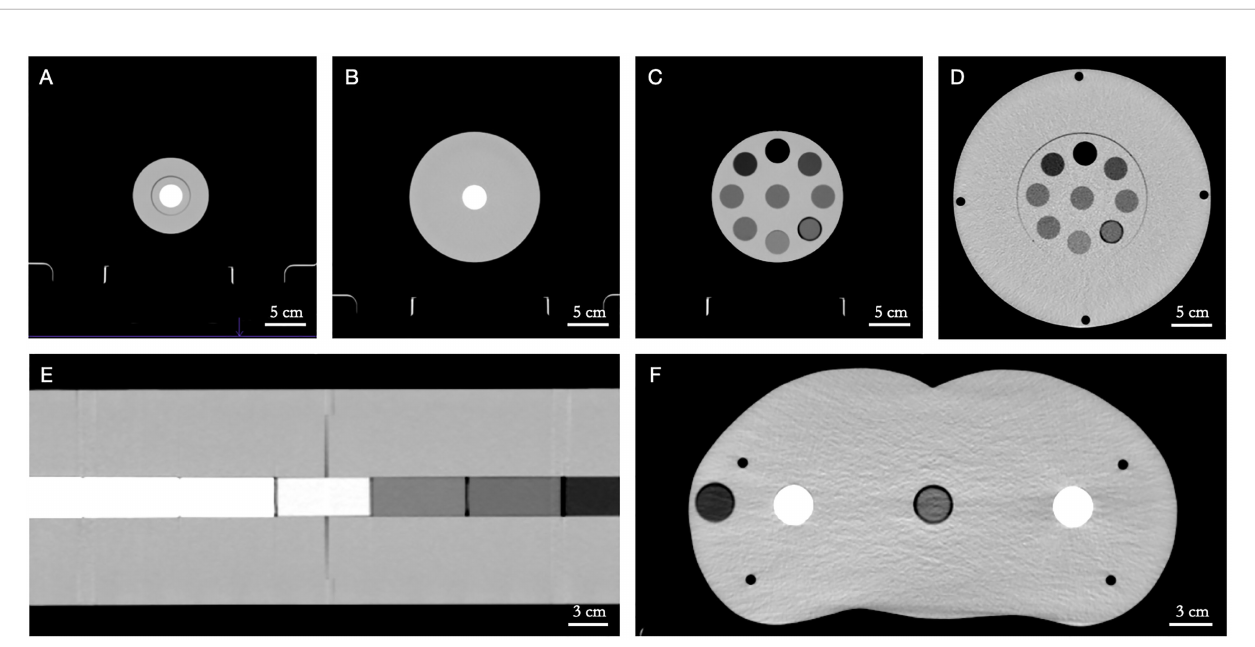
FIGURE 1 | Custom polymethyl methacrylate (PMMA) phantoms with tissue-equivalent inserts in axial view. (A) LCT ( “ long cylinder thin ” ) phantom, (B) LC ( “ long cylinder ” ) phantom, (C) SC ( “ short cylinder ” ) phantom, (D) SCB ( “ short cylinder big ” ) phantom, (E) LC ( “ long cylinder ” ) phantom (in coronal view), (F) pelvis phantom. Window level/window width = 40/400